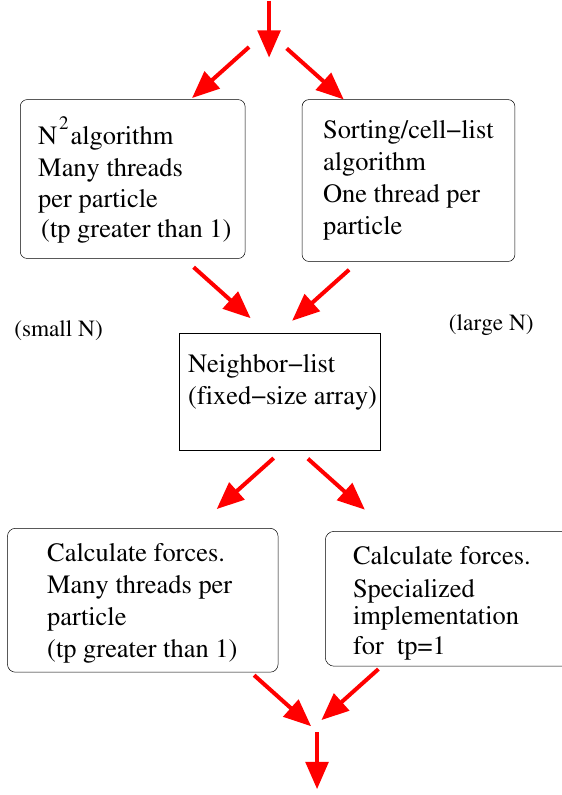
Figure 2: Schematic diagram representation of the two algorithms for neighbor-list generation, and the force calculation algorithm. The latter uses multiple threads per particle (tp), but an implementation also exists for the special case tp =